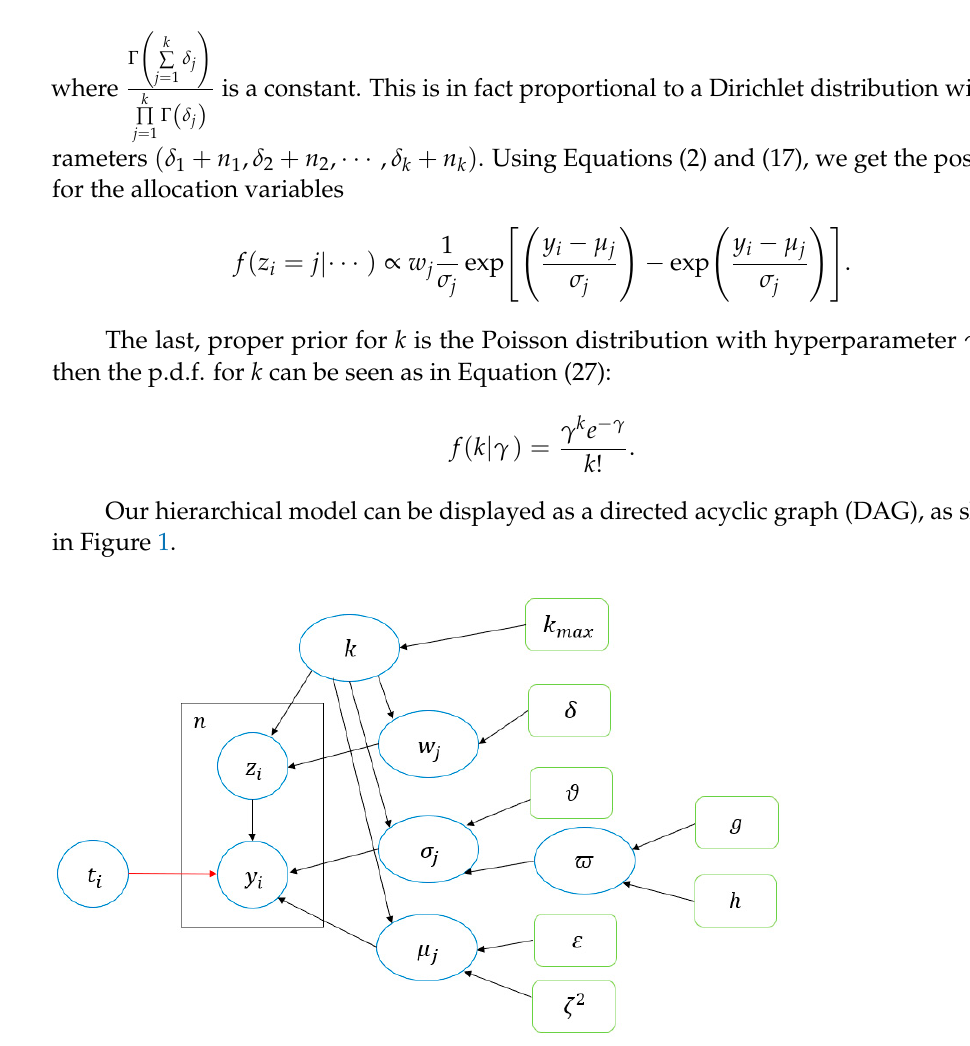
Figure 1. Graphical representation of the Bayesian hierarchical finite EV-I mixture distribution. Nodes in this graph represent random variables, green boxes are fixed hyperparameters, boxes indicate repetition (with the number of repetitions in the upper left), arrows describe conditional dependencies between variables, and the red arrow describes a variable transformation.